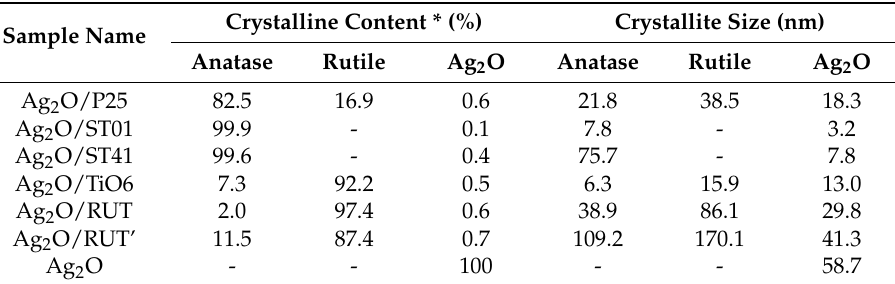
Table 1. Properties of Ag 2 O/TiO 2 photocatalysts.